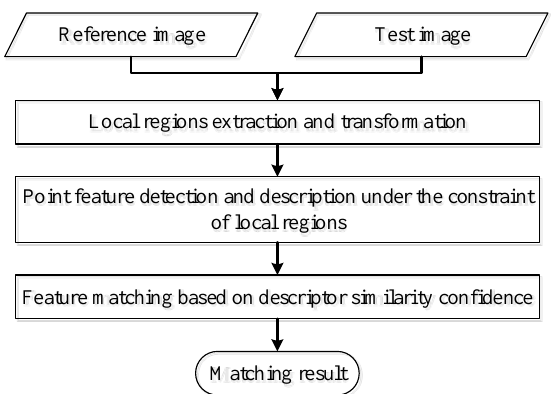
Figure 3. Flowchart of the proposed